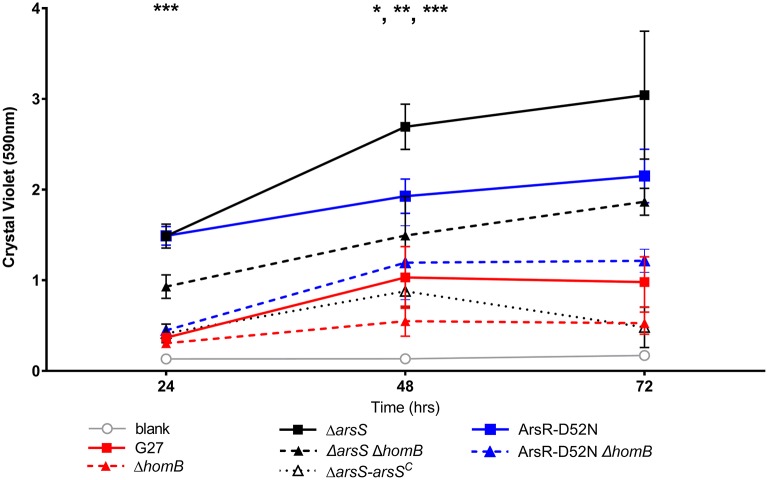
Crystal violet biofilm quantification. Solubilized crystal violet stain was read at an OD590 and plotted over time. The mean absorbance for a minimum of three biologically independent replicates is indicated by each line. For all data sets, error bars show the standard error of the mean. An asterisk indicates significant biofilm formation compared to the blank at a given timepoint (*p < 0.05, **p < 0.01, ***p < 0.001). By 24 h, significant biofilm formation was observed for ΔarsS vs. blank (p = 0.0005) and ArsR-D52N vs. blank (p = 0.0005); significant biofilm formation was observed by 48 h for wild-type vs. blank (p = 0.0350), ΔarsSΔhomB vs. blank (p = 0.0005), and ArsR-D52NΔhomB vs. blank (p = 0.0088).